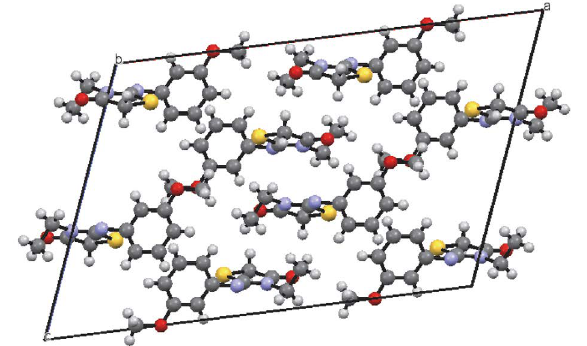
Figure 3. View of the crystal packing along the b axis of ( Z )-3- N - (ethyl)-2- N ’-((3-methoxyphenyl)imino)thiazolidine-4-one mole-